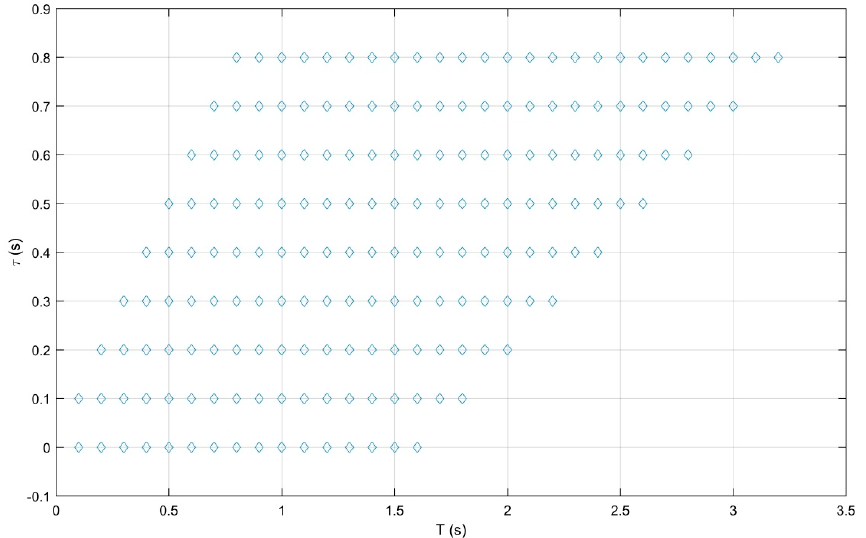
Figure 16. Stabilization ranges of sampling period and sampling delay ( (cid:1865) = 0 ).